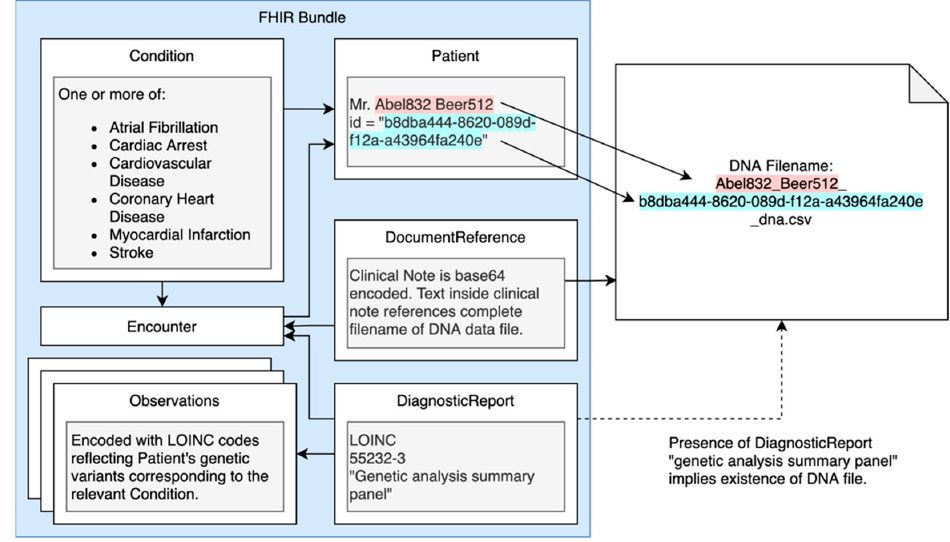
Figure 2. The relationship of FHIR Resources to the synthetic DNA data. A diagnostic report and observations relating to a synthetic genome of the patient are generated during an encounter and then added to their health record. The DNA data file is referenced by a DocumentReference resource within the HL7 FHIR Patient Bundle.